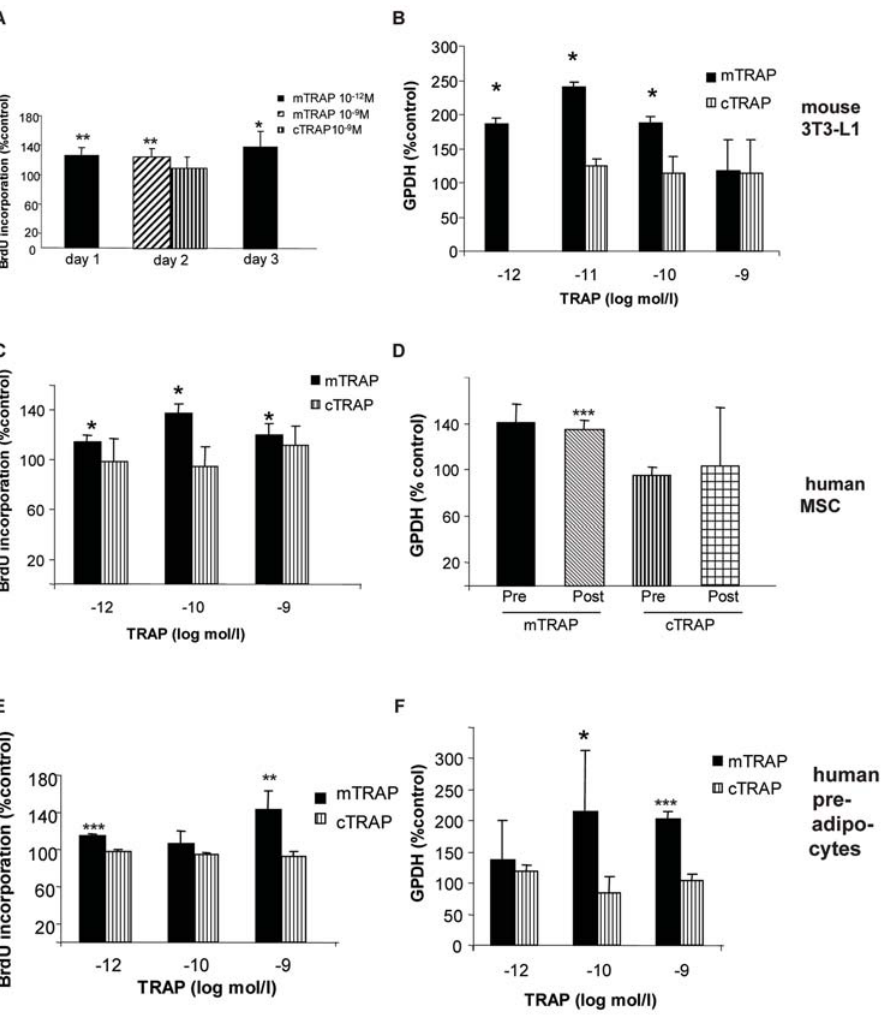
Figure 4. Stimulation of adipocyte proliferation and differentiation by monomeric TRAP but not proteolytically processed TRAP. The following cells were used: Mouse 3T3-L1 preadipocytes (A, B), Human mesenchymal stem cells (hMSC) (C, D) and human pre-adipocytes (E, F). Proliferation (BrdU) was assessed after 1 day (3T3-L1), 2 days (3T3-L1, hMSC), 3 days (3T3-L1) or 5 days (pre-adipocytes) after seeding. Differentiation (GPDH-activity) was measured 4 days (3T3-L1) or 12 days (hMSC, pre-adipocytes) after start of differentiation. hMSC were treated with TRAP either before (Pro) or at (Post) confluence. mTRAP=monomeric TRAP, cTRAP=proteolytically processed TRAP. Data are expressed as percentage of control. Statistical analysis was performed using T-test, * p , 0.05, comparing control cells with stimulated